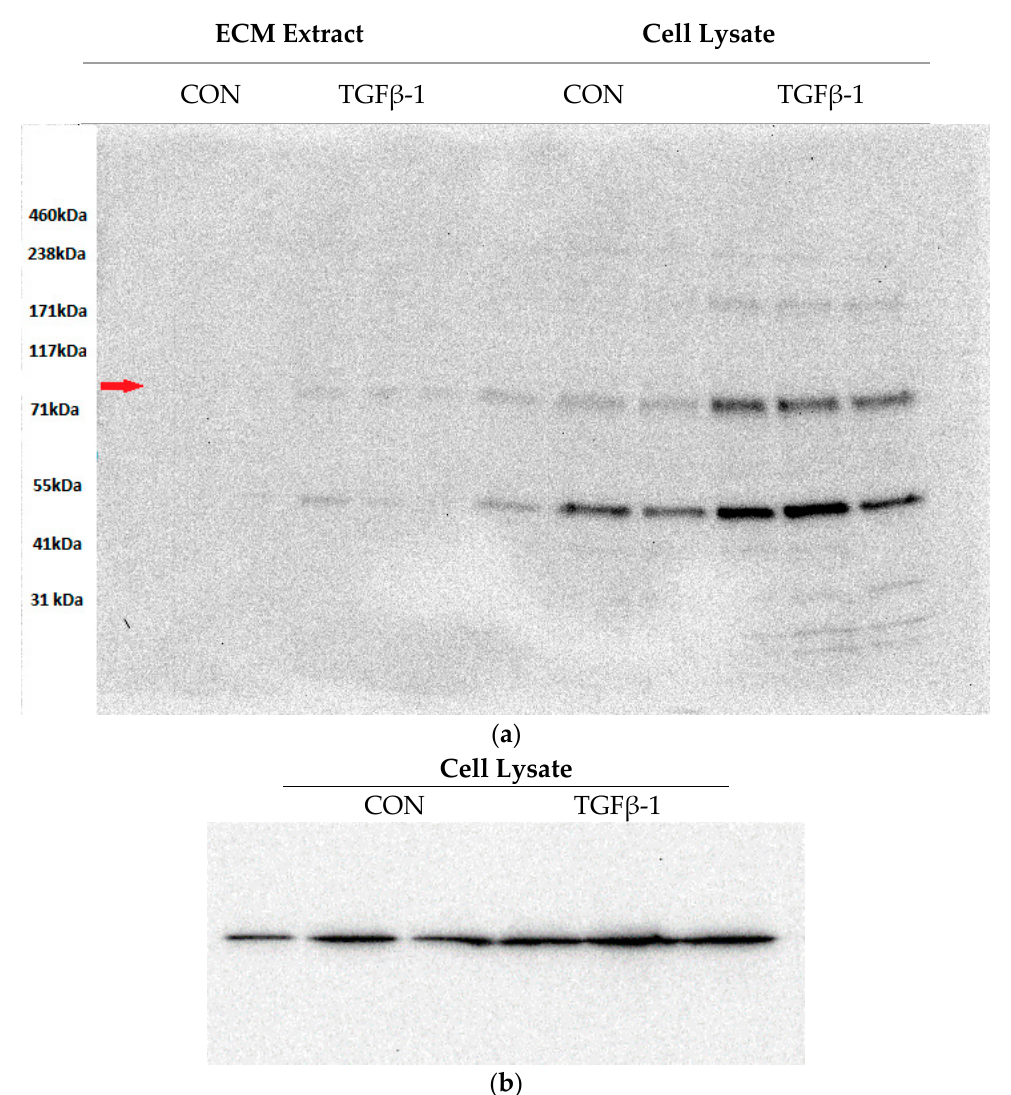
Figure 2. LH2 Western blot analysis of the 20-day stimulation of cultured dermal fibroblasts with TGF β -1. ECM preparations from control or TGF β -1-treated cultures, and cell lysate preparations from control and TGF β -1-treated cultures were immunoblotted for LH2 ( a ), where the bands matching the expected enzyme molecular weight (85 kDa) are indicated with an arrow. The cell lysates were also immunoblotted for GAPDH ( b ); ( n = 3).